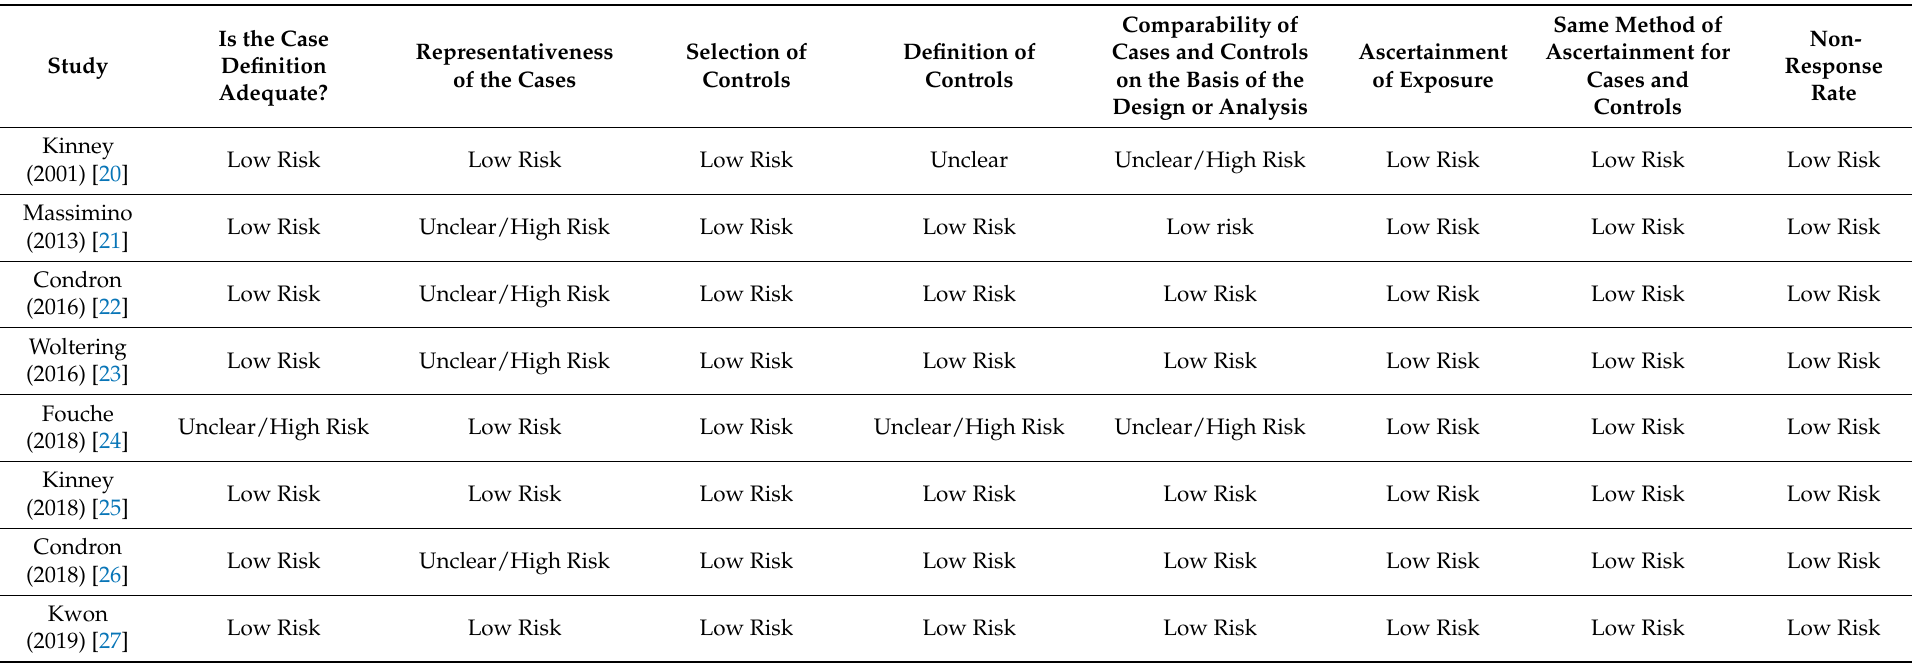
Table A1. Risk of bias